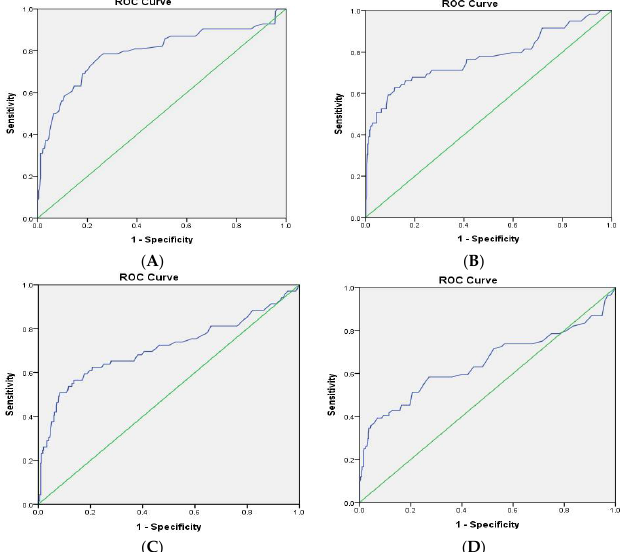
Figure 1. Receiver operating characteristic (ROC) curves were generated to compute the area under the ROC (AUROC), the best threshold, and the corresponding sensitivity and specificity for all four glycemic indicators on the incidence of surgical site infection during postoperative 1 year: The green lines represents the reference lines and the blue lines represented the differentiation power at the different thresholds of the glycemic indicators.( A ) preoperative HbA1c (AUROC = 0.793; 95% CI: 0.730–0.856); ( B ) preoperative blood glucose (AUROC = 0.773; 95% CI: 0.694–0.851); ( C ) postoperative blood glucose (AUROC = 0.709; 95% CI: 0.629–0.790); ( D ) postoperative HbA1c (AUROC = 0.648; 95% CI: 0.570–0.726).